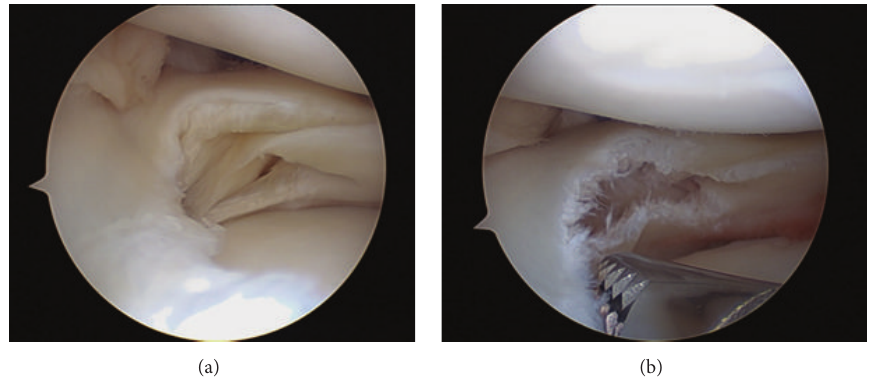
Figure 3: (a) Lateral meniscus complex lesion. (b) Lateral meniscus after minimal resection.